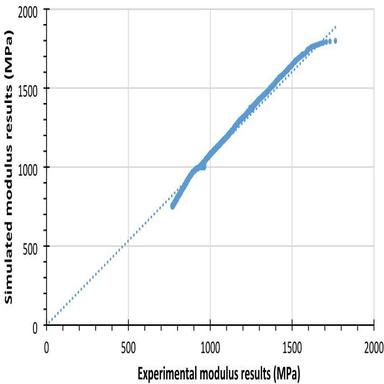
Correlation between simulated and experimental results: strain-controlled fatigue test .